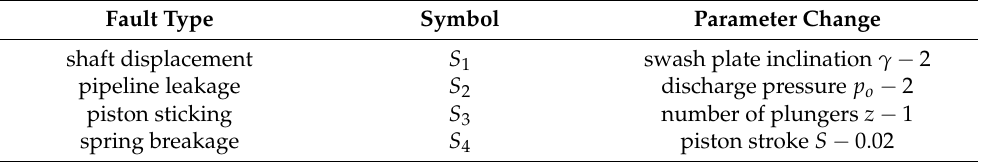
Table 2. Fault Simulation